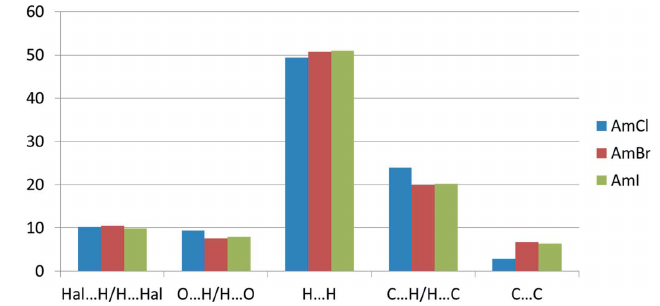
Figure 4 Hirshfeld surfaces of the cation in the ( a ) AmCl , ( b ) AmBr and ( c ) AmI salts mapped over d norm .